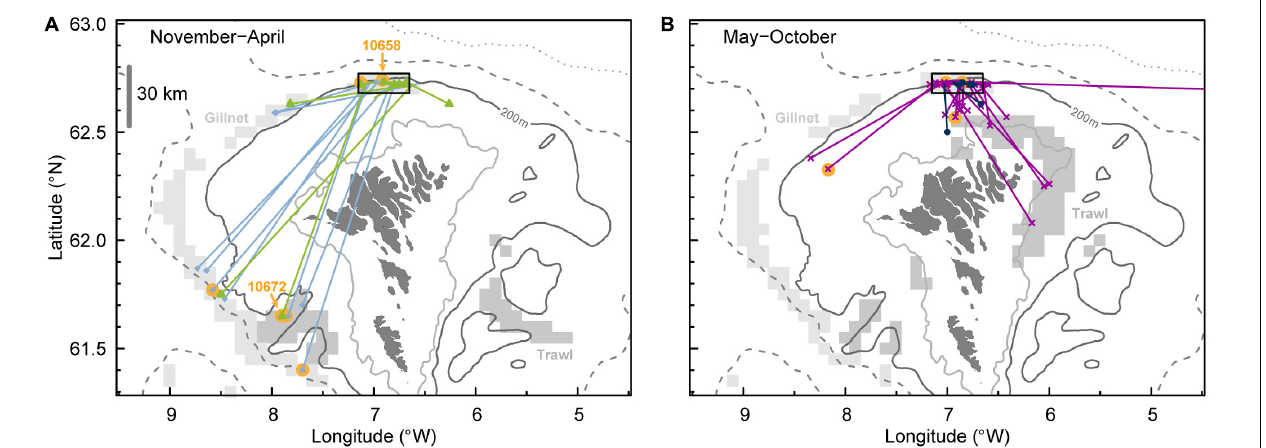
FIGURE 8 | Horizontal movements of anglerfish tagged from gillnet north of the Faroe Islands (black rectangle) mainly in May–August. Recaptures during winter/spring are shown in panel (A) , differentiated between November–February (light blue) and March–April (lime). Recaptures during summer/fall are shown in panel (B) , differentiated between May–August (purple) and September–October (dark blue). The orange dots represent recapture of anglerfish with data storage tags and results from DST 10672 and DST 10658 are presented in Supplementary Figures 2, 3 . Depth contours are shown for 100, 200, 500 (dashed), and 1,000 m (dotted). The main fishing areas are presented for small trawlers (gray rectangles) and gillnetters (light gray rectangles) (from Figure 3 ).